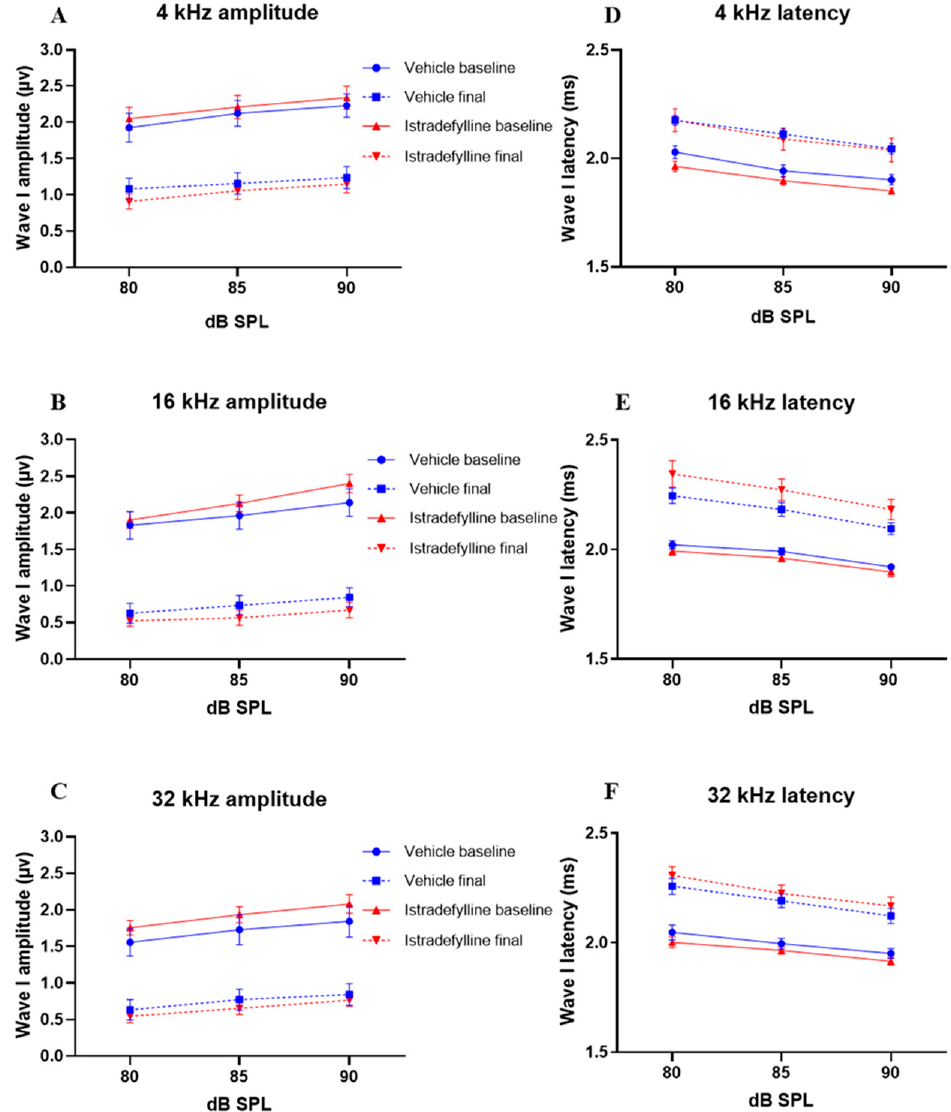
Figure 2. Average baseline (6 months) and final (12 months) ABR wave I amplitudes ( A – C ) and latencies ( D – F ) at 4, 16, and 32 kHz. Amplitudes and latencies were recorded at suprathreshold intensities (80–90 dB SPL) in mice treated with istradefylline or drug vehicle solution. Solid lines represent baseline amplitudes/latencies and dashed lines represent final amplitudes/latencies. Data presented as mean ± SEM. Vehicle control, n = 13; istradefylline, n = 12. Overall, the basal turn was most affected in ageing mice and showed the greatest hair cell loss. Treatment with istradefylline induced significant improvement in IHC and OHC survival in both middle and basal turns of the cochlea (Figure